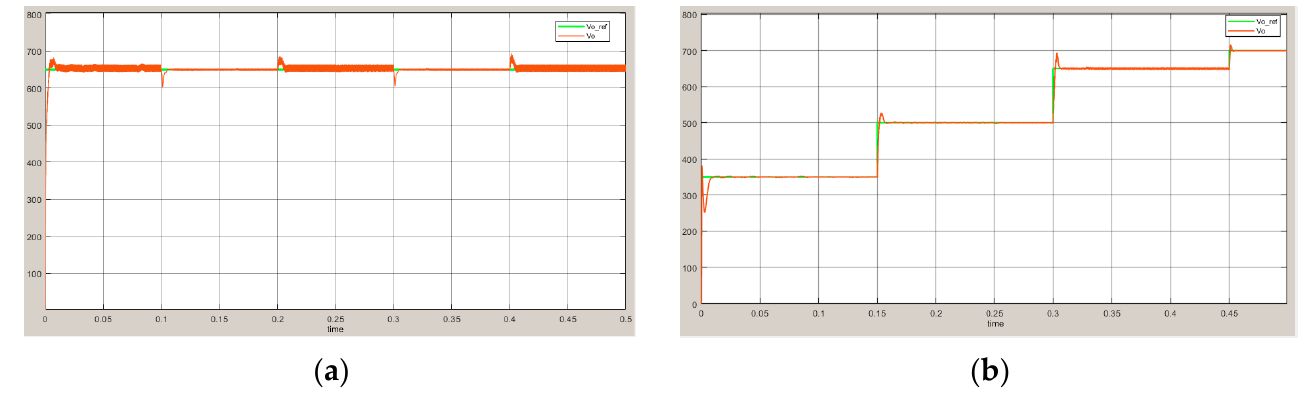
Figure 5. The effect of controller under working state 1 and 2: ( a ) output voltage under load switching conditions; ( b ) output voltage following the desired value schematic.